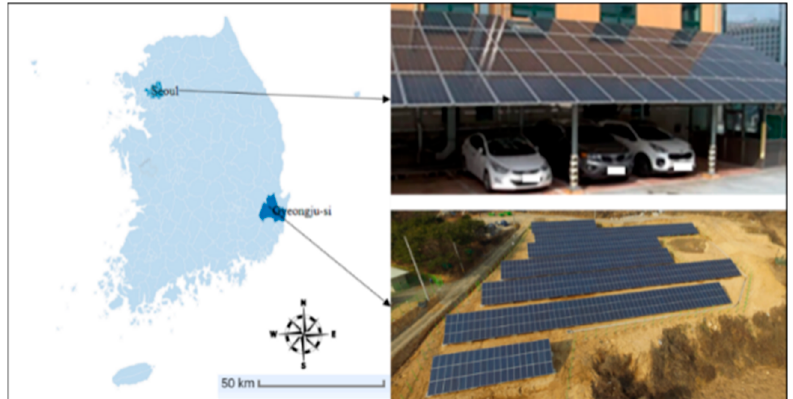
Figure 2. Locations of the study areas.